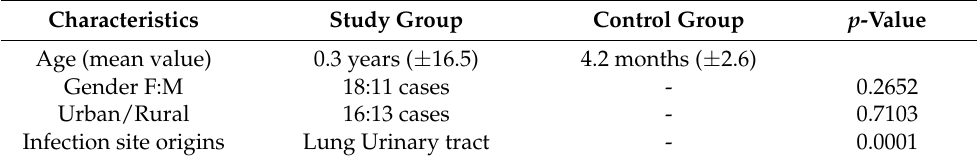
Table 2. Demographical and epidemiological data in the study group and control group.